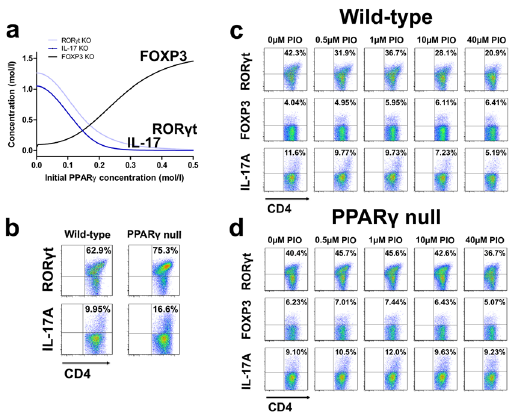
Figure 2. Activation of peroxisome proliferator-activated receptor c (PPAR c ) regulates differentiation of CD4 + T cells. (A) Computational simulation of the effect of in silico activation of PPAR c in a T helper (Th)17 cell on the levels of FOXP3, IL-17 and ROR c t. (B) PPAR c inhibits Th17 differentiation. Naı¨ve wild-type CD4 + T cells differentiated with IL-6 in combination with TGF- b in vitro for 60h express less ROR c t and produce lower levels of IL-17A when compared to T cell-specific PPAR c null Th17 cells. (C) Increasing concentrations of pioglitazone (PIO), a full PPAR c agonist, upregulate FOXP3 in wild-type Th17 differentiated cells following 24 h treatment and down-regulate ROR c t and IL-17A in wild-type cells. (D) Increasing concentrations of PIO do not have an effect in PPAR c null Th17 cells. The double-positive region can be observed in the upper right part of the flow plots.